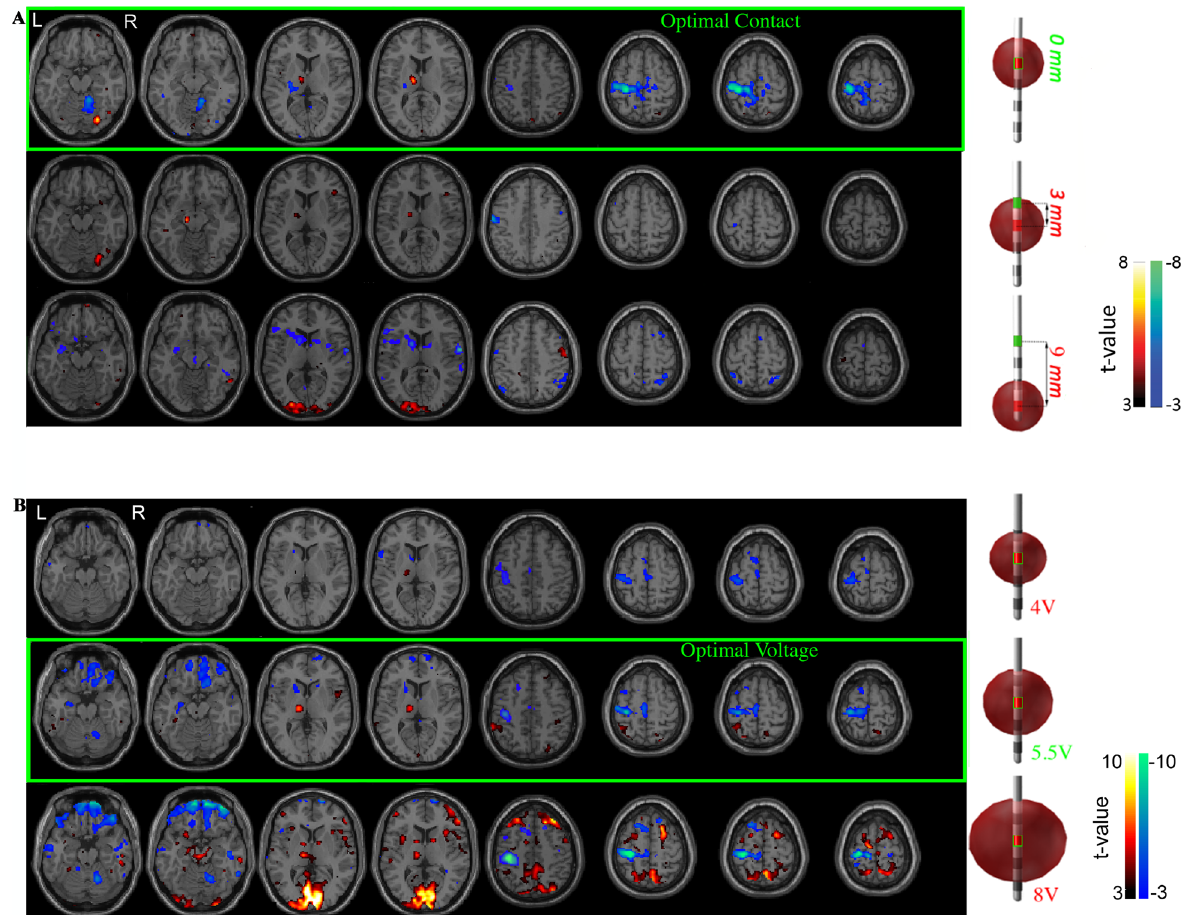
Fig. 3 Typical pattern of fMRI changes resulting from different settings. BOLD response maps associated with left DBS-STN stimulation at multiple DBS lead A Contacts and B voltages for two a priori clinically optimized PD-STN patients. The fMRI BOLD signal changes at the optimal contact ( A top row) and voltage ( B middle row) are shown. Brain regions with a signi fi cant increase (hot colors, positive t -values, DBS-ON > OFF) and decrease (cool colors, negative t -value, DBS-ON < OFF) ( p < 0.001, cluster size = 50) in BOLD response were identi fi ed. A The optimal contact showed changes in BOLD response in the left (ipsilateral) motor cortex and thalamus, and right (contralateral) cerebellum. We considered the clinically optimal contact as the origin (i.e., 0) and the non-optimal contacts were mapped as a function of distance in mm from the optimal contact. B When using the optimal stimulation contact, decreasing stimulation amplitude from optimal to low (subtherapeutic) voltage stimulation triggered a decrease in magnitude of the BOLD changes but maintained the topographic pattern. High (supratherapeutic) voltages produced a relatively stronger BOLD response in the left (ipsilateral) motor cortex and right (contralateral) cerebellum but was also accompanied by increased BOLD signal in non-motor regions such as the inferior frontal and occipital lobes. The subtherapeutic voltage was de fi ned as 1.5 V below optimal voltage because a reduction of this magnitude yields a change in clinical status for most PD patients. The supratherapeutic voltage was de fi ned as the voltage just below the side effects threshold (i.e., highest tolerated voltage). BOLD blood-oxygen-level-dependent, DBS deep brain stimulation, fMRI functional magnetic resonance imaging, PD Parkinson ’ s disease, STN subthalamic